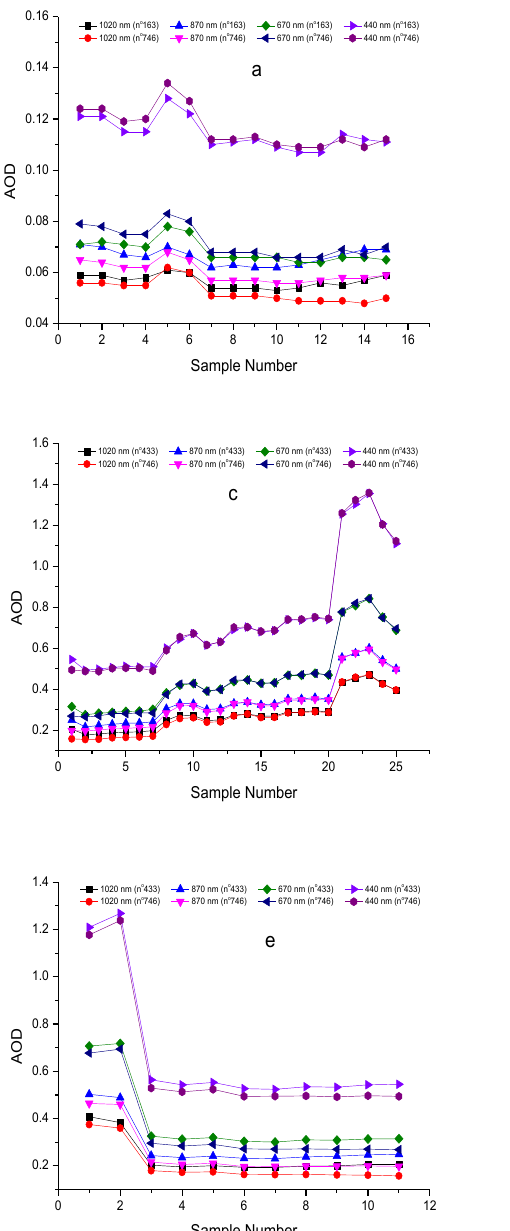
Figure 5. Comparison of the result of AOD retrieved at 1020 nm, 870 nm, 670 nm and 440 nm between the reference instrument and the experiment instruments under the effects of five factors: ( a ) spider web inside the collimator; ( b ) collimator bending; ( c ) dust inside the optical head; ( d ) incrustation scale inside the optical head; and ( e ) dust and incrustation scale inside the optical head.